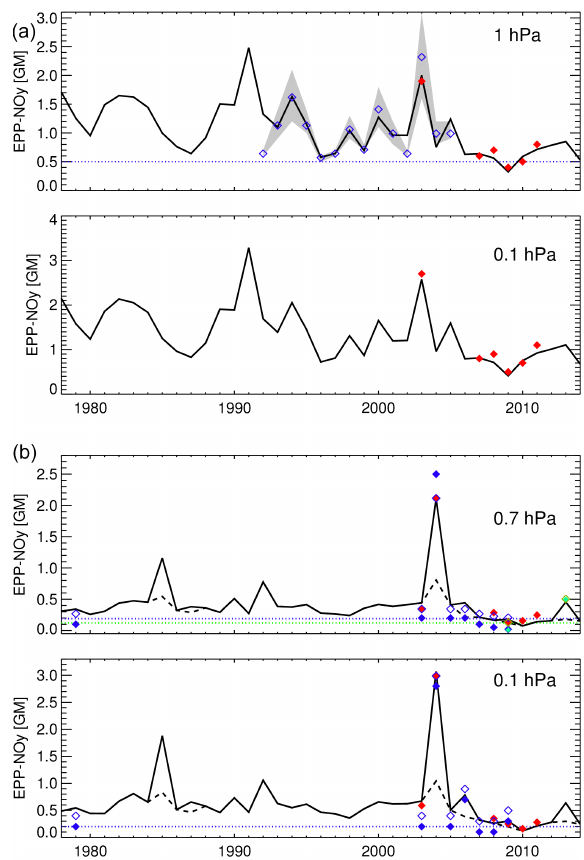
Figure 10. (a) Inter-annual variation of seasonal EPP-NO y deposi- tions during 1978–2014 calculated with the semi-empirical model in the SH below the pressure levels of 1hPa (top) and 0.1hPa (bottom). EPP-NO y deposition estimates from MIPAS observa- tions (Funke et al., 2014b) are indicated by filled red diamonds. HALOE-derived estimates of Randall et al. (2007) are shown by the grey-shaded area (limited by their “average” and “maximum ex- cess NO x ” estimates) and are shifted by 0.5GM (dashed blue line) in order to facilitate comparisons to the MIPAS estimates. Open blue symbols represent the adjusted “maximum excess” estimates (scaled by a factor of 0.7 to fit the MIPAS estimates). (b) As for panel (a) but for the NH and for the 0.7hPa (top) and 0.1hPa (bot- tom) levels. Modeled EPP-NO y depositions without consideration of ES events are also shown by dashed lines. Observational deposi- tion estimates from satellite data are also shown: MIPAS (Funke et al., 2014b) (filled red diamonds); MIPAS (2003–2004), ACE- FTS (2005-2009), and LIMS (1979) (Holt et al., 2012) (filled blue diamonds); SOFIE (2009–2013) (Bailey et al., 2014) (filled green diamonds). Open blue and green symbols represent the adjusted es- timates of Holt et al. (2012) and Bailey et al. (2014), respectively, after applying a constant offset (colored dotted lines) and an scale factor in order to facilitate comparisons with the MIPAS-derived depositions of Funke et al. (2014b) (see text for more details). Note that years indicated on the x axis correspond to the second year of the season; e.g., “2003” means “winter